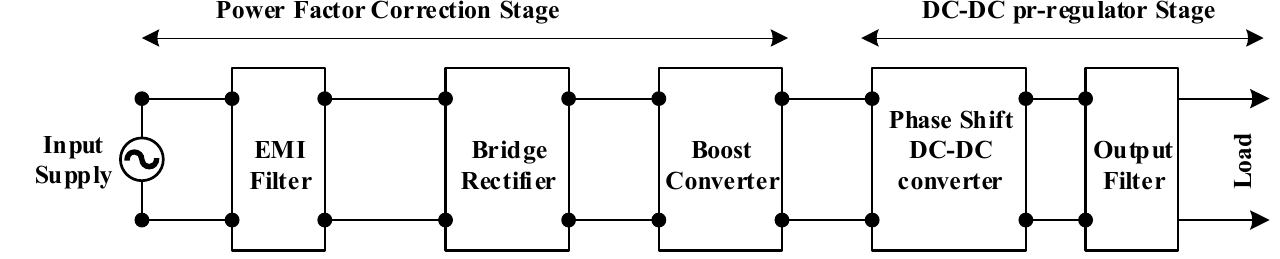
Figure 1. Construction of the industrial high-power density telecom power supply.